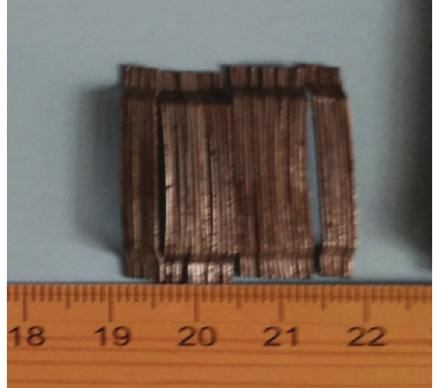
Figure 1: Glued steel fibres used in the